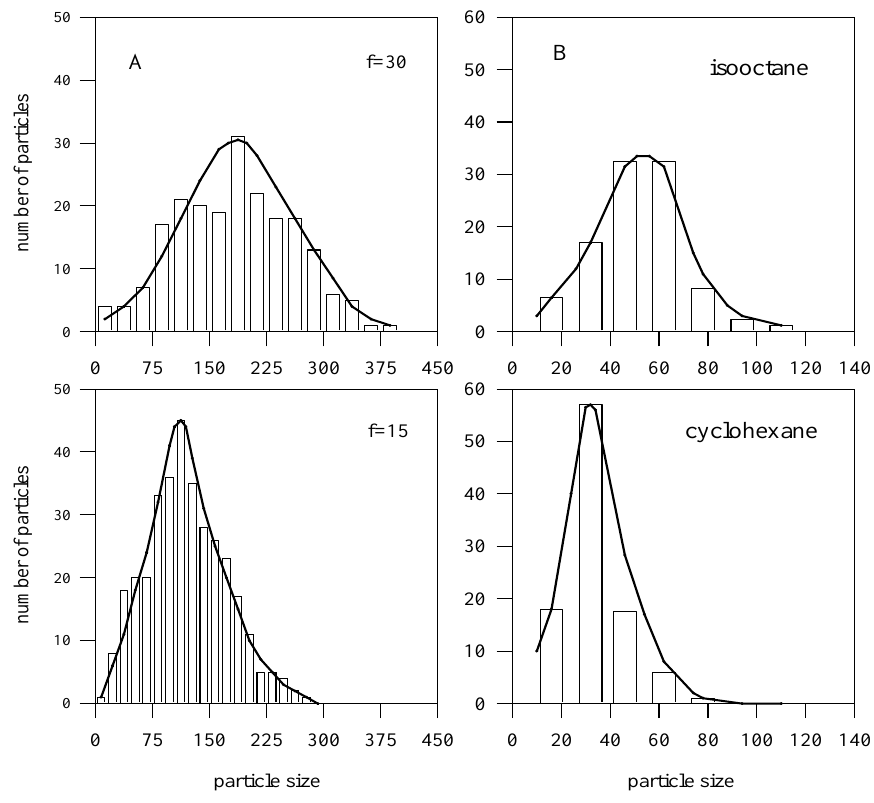
Figure 2. ( A ) Simulation results for  c  = 100 and different f values ( f = 30, top panel; f = 15, bottom panel). ( B ) Size distributions of silver particles synthesized in isooctane (top) and cyclohexane (bottom) (data obtained from reference  55  ). The lines are simply a guide for the